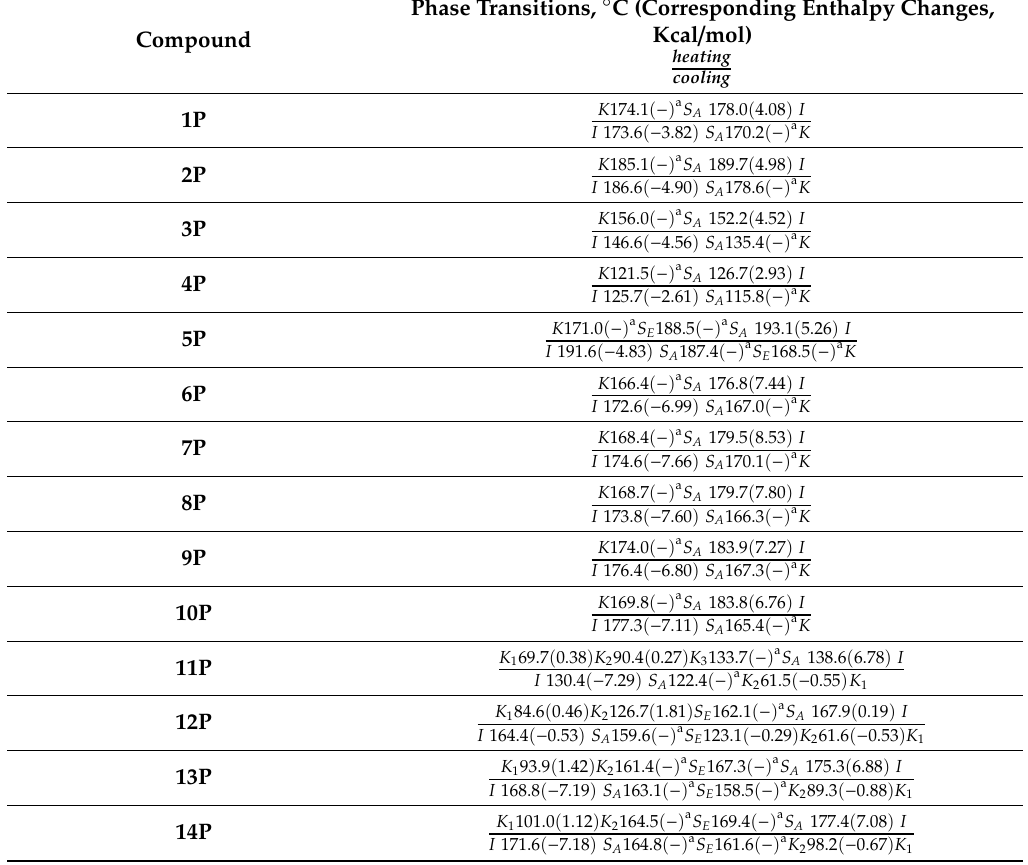
Table 2. Phase transition temperature and thermodynamic parameters of polymers 1P ~ 18P . Phase Transitions, ◦ C (Corresponding Enthalpy Compound